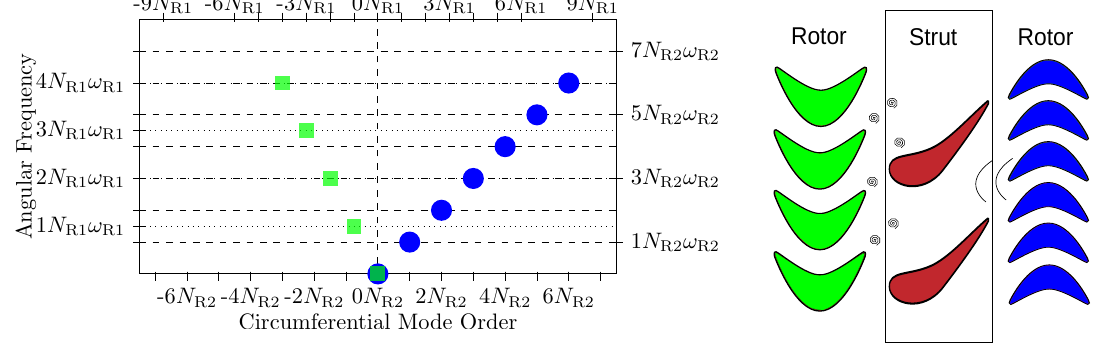
Figure 2. Green and blue harmonic sets represent the unsteady disturbances caused by two neighbouring blade rows with different rotational speeds whose blade count ratio is